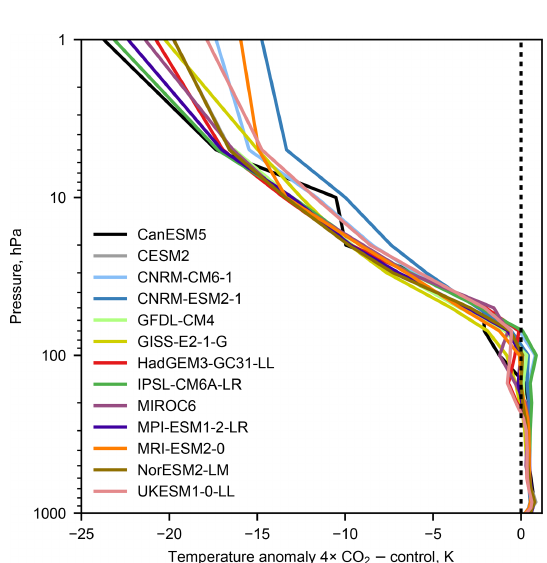
Figure 4. Atmospheric temperature differences for RFMIP mod- els for the piClim-4 × CO 2 experiment minus piClim-control exper-